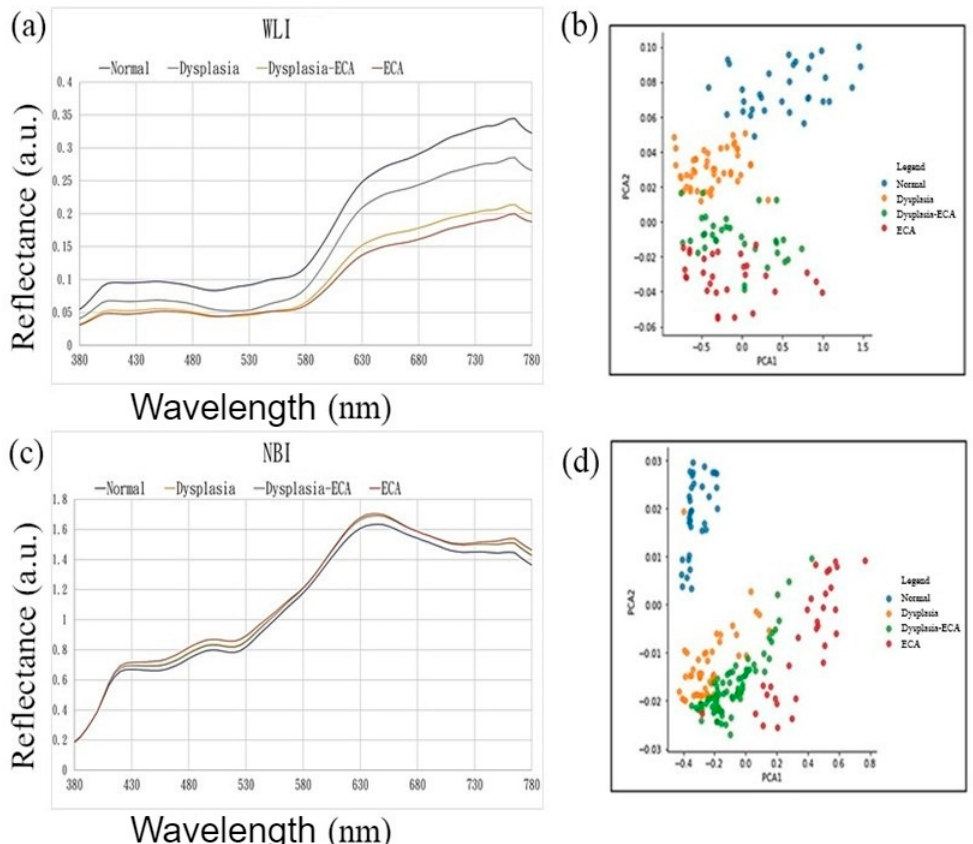
Figure 3. White-light and narrow-band endoscopic imaging of esophageal cancer spectrum and dimensionality reduction data distribution map. ( a ) White-light endoscopic images of esophageal cancer spectrum; ( b ) white-light endoscopic images of esophageal cancer spectrum dimensionality reduction data in the first two principal components of the data distribution map; ( c ) narrow-band endoscopic imaging of esophageal cancer spectrum; ( d ) narrow-band endoscopic imaging of esophageal cancer spectrum dimensionality reduction data in the first two principal components of the data distribution map.